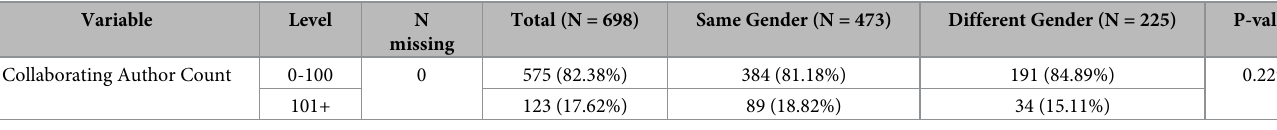
Table 12. Publication characteristics for first/last author same gender teams (2008 –